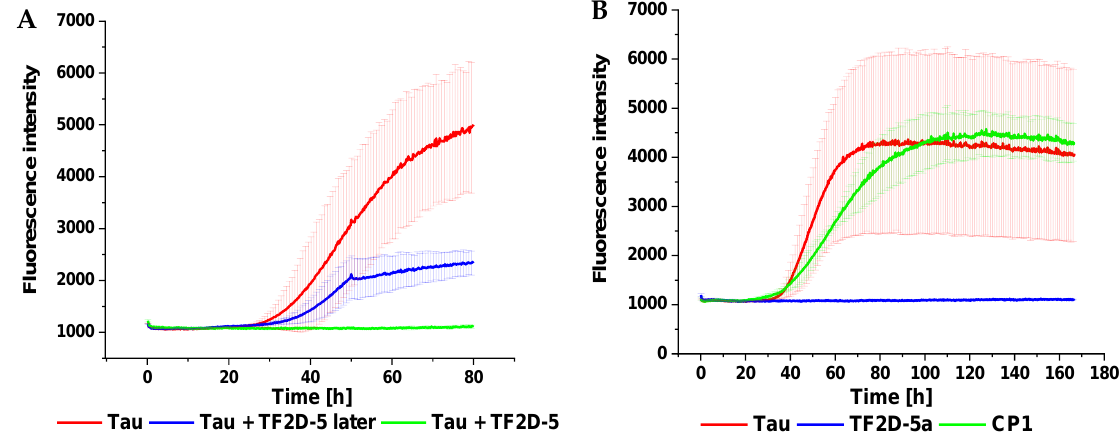
Figure 5. Tau aggregation-influencing effect of TF2D-5 and TF2D-5a. The ThT assay was performed in a FLUOstar plate reader from BMG Labtech. Twenty-five micrometers recombinant full-length tau 441 was mixed with 12.5 µM heparin, 200 µM DTT, 0.05% NaN 3 , and 20 mM ThT. Compounds were added with a concentration of 25 µM. The total volume was adjusted to 100 µL with PBS pH 7.4, and the plate was measured with bottom optics. The experiment ran at 37 °C with measurement intervals of 20 min. Before each measurement, the plate was shaken for 15 s at 300 rpm. A 3 mm borosilicate bead was added to each well. ( A ) The effect of TF2D-5 when added at different time points during the ThT assay. When added at the start of the experiment no aggregation can be observed for the duration of the experiment (green). When added during the exponential phase at time point 48 h, the aggregation slows immediately and then stops (blue). ( B ) The addition of TF2D-5a to the sample inhibits tau aggregation during the complete experiment which equals a lag time increase of at least 400% (blue). The addition of control D-peptide 1 (CP1) did not exhibit the same effect as the addition of the other compounds (green). CP1 was obtained by randomizing the amino acid residue composition of TF2D-5.